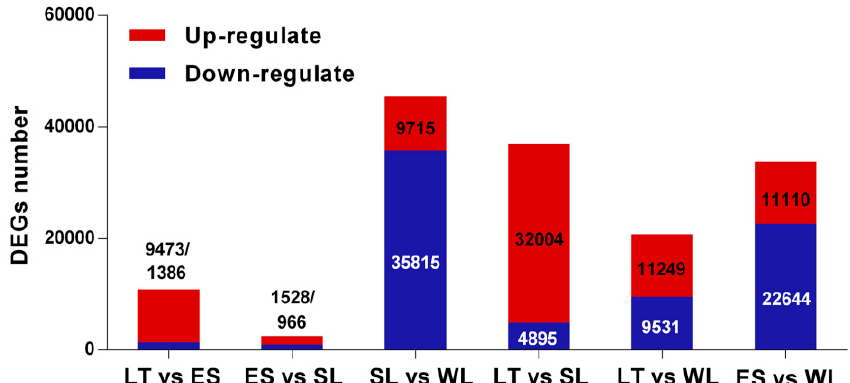
Figure 3. DEGs profiles of U. unicinctus larval transcriptome with a pairwise comparison of each time point.